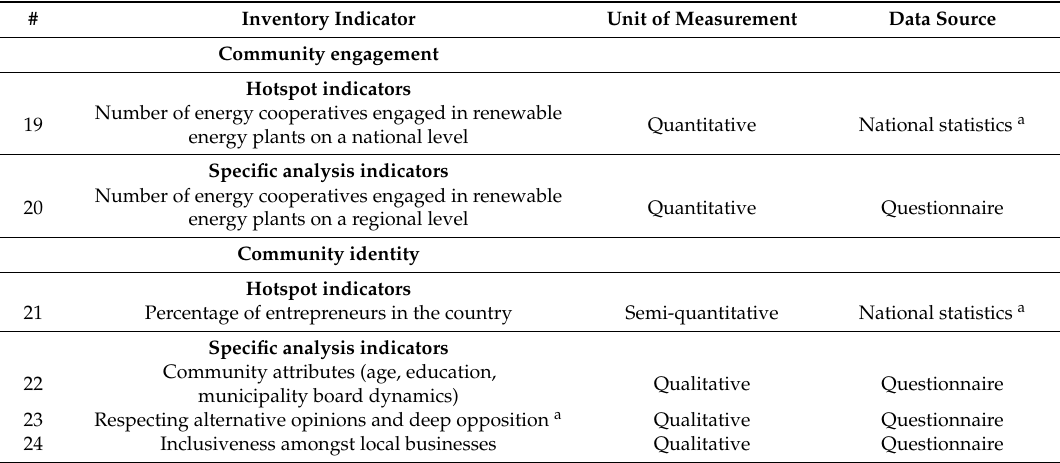
Table 4. Local communities’ subcategories and